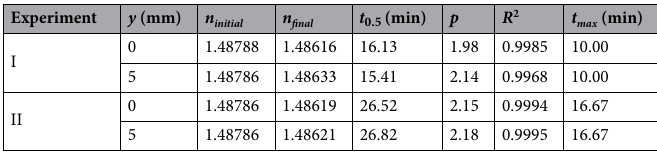
Table 1. Values of the toluene logistic fittings’